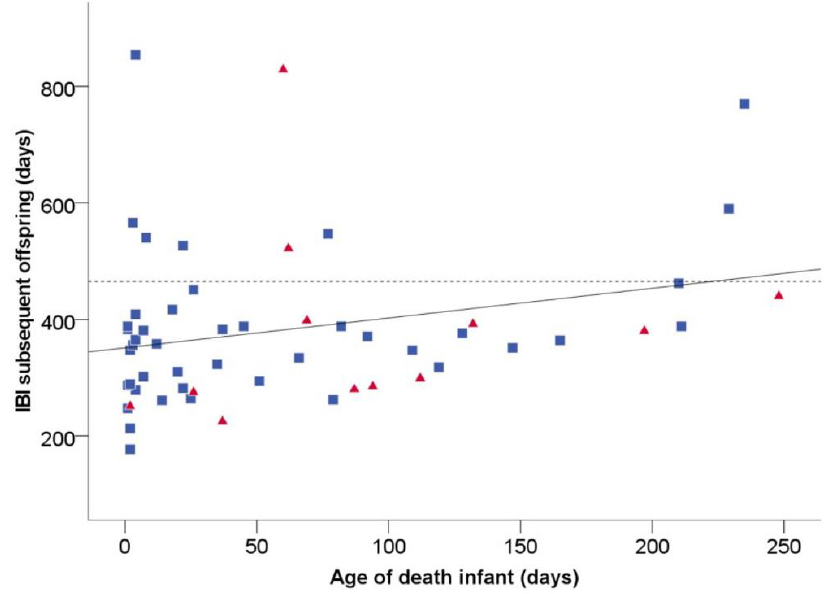
Figure 1. Relationship between the age of death of an infant (x-axis) and the interbirth interval to the subsequent offspring (y-axis). The scatterplot shows a linear relationship (continuous line) between the age of death of an infant and the IBI of the next offspring (IBI = 0.52 * (age at death) + 353). The horizontal dotted line represents the average IBI to the subsequent offspring after surviving offspring (465 days). The point at which the horizontal line crosses the regression line marks the age of an infant under which infanticide can decrease the IBI [52], which is 215 days. Blue blocks represent infants that died from a natural cause, and red triangles represent infants that died from infanticide.